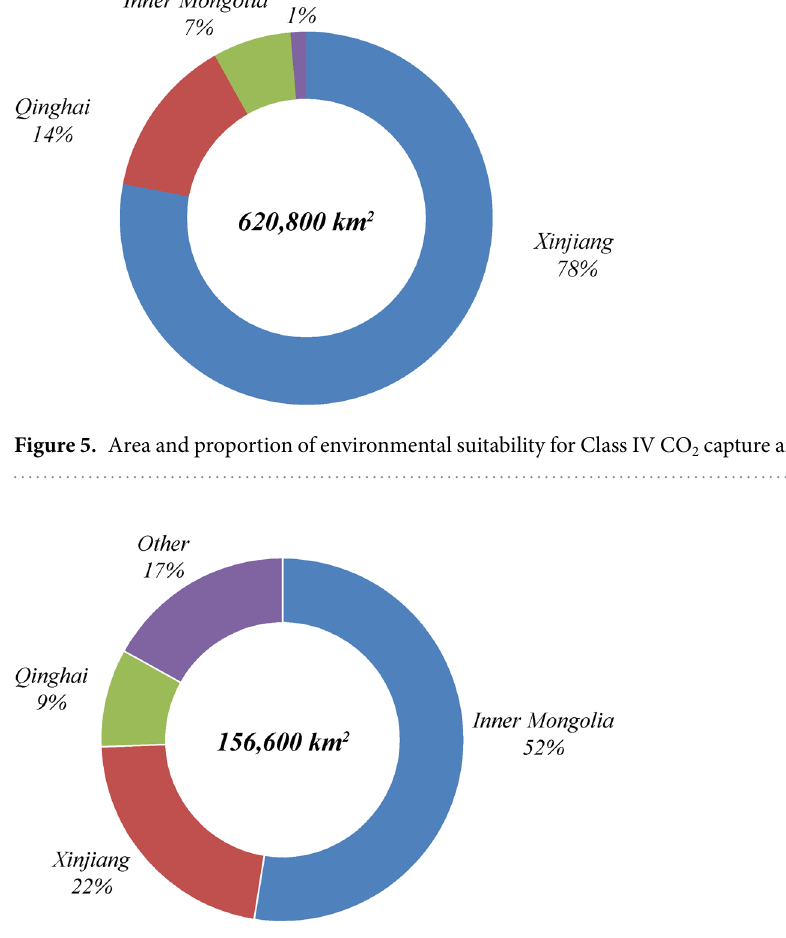
Figure 6. Area and proportion of environmental suitability for Class III CO 2 capture and storage sites in China.